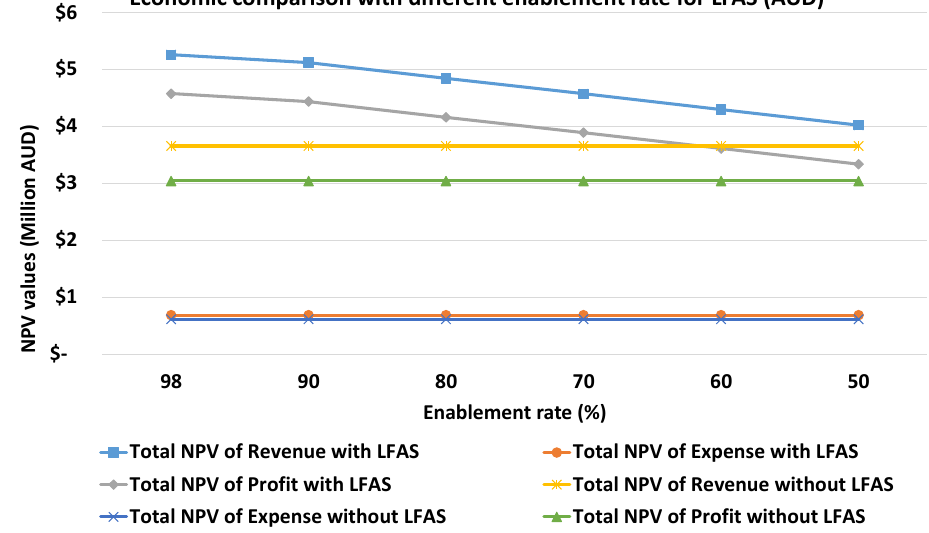
Figure 4. The average NPV values of total revenue, expense, and profit with different levels of enablement rate (%) for the LFAS market and without the LFAS market.